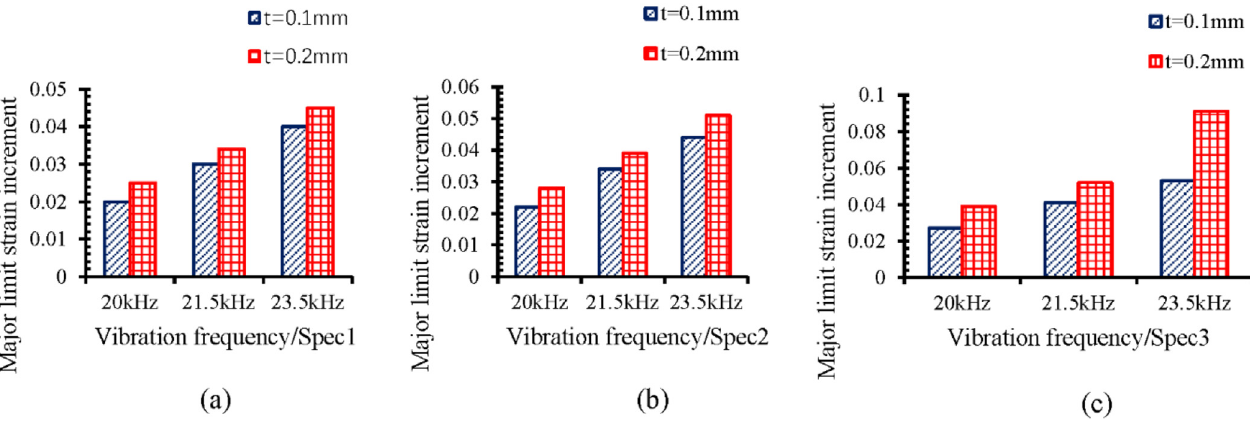
Fig. 6. Limit strain increment of specimens with different frequencies. (a) spec1. (b) spec2. (c)